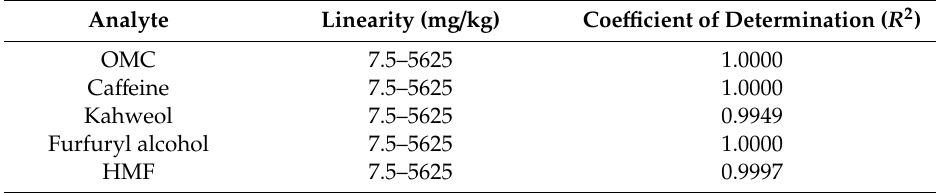
Table 8. Linear concentration range of the co ff ee analytes (also see Supplementary Figure